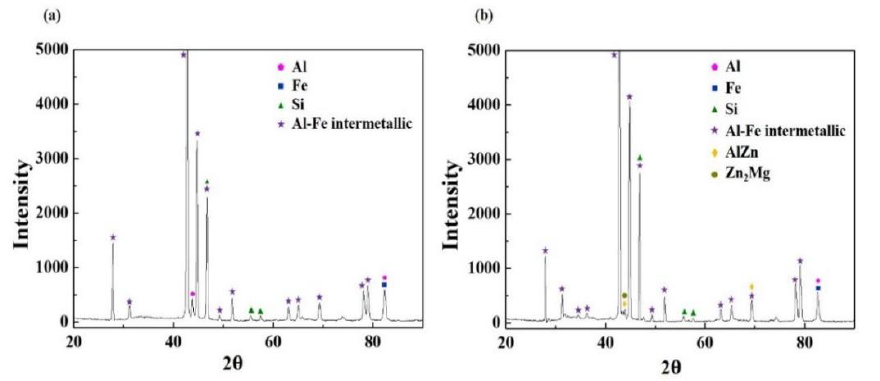
Figure 3. X-ray diffraction patterns of ( a ) AlSi-MC and ( b ) AlSiZnMg-MC.